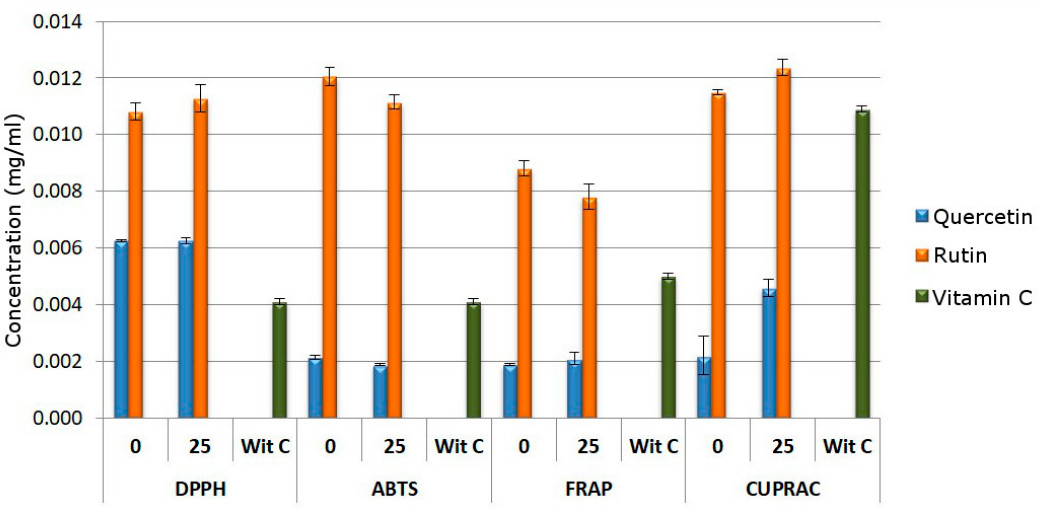
Figure 4. Summary of the results of antioxidant properties. IC 50 value in DPPH and ABTS assay and IC 0.5 value in FRAP and CUPRAC assay.